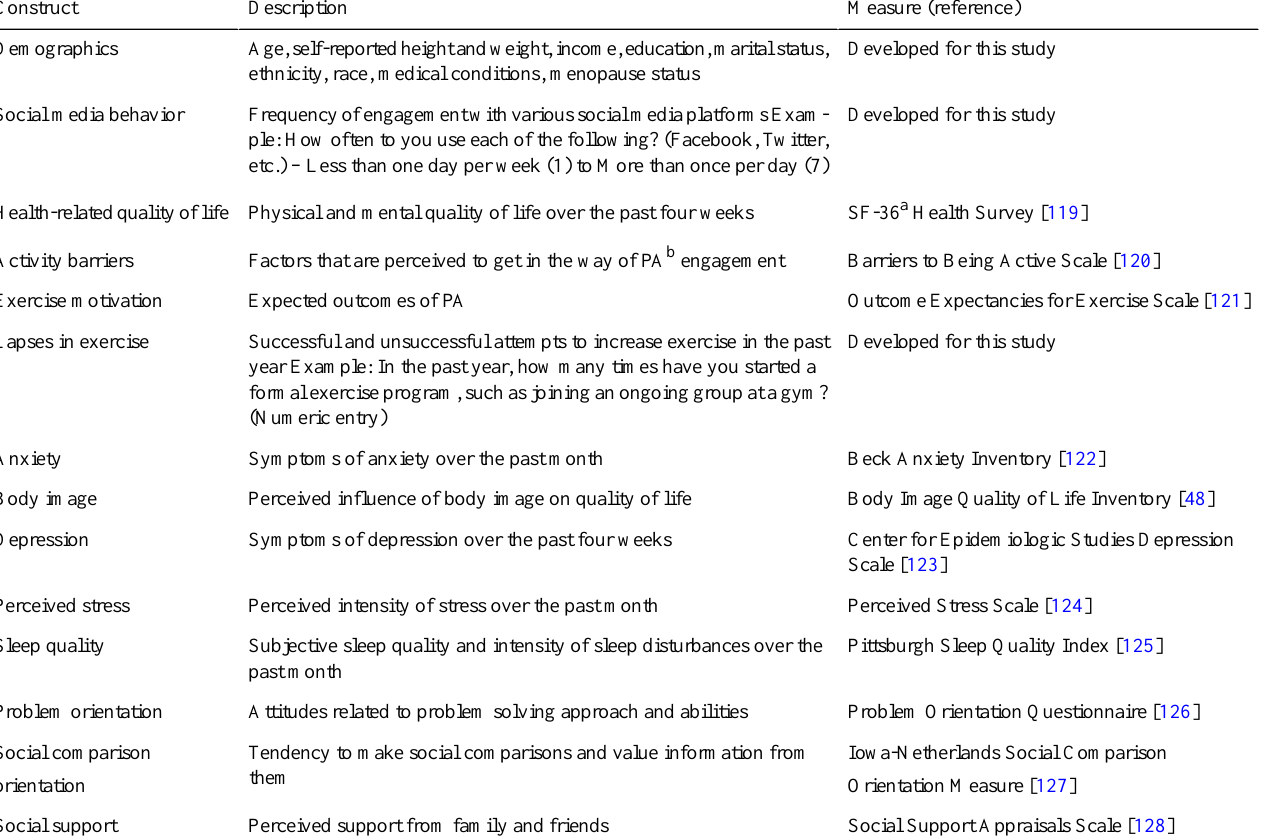
Measure (reference)DescriptionConstruct Developed for this studyAge, self-reported height and weight, income, education, marital status,